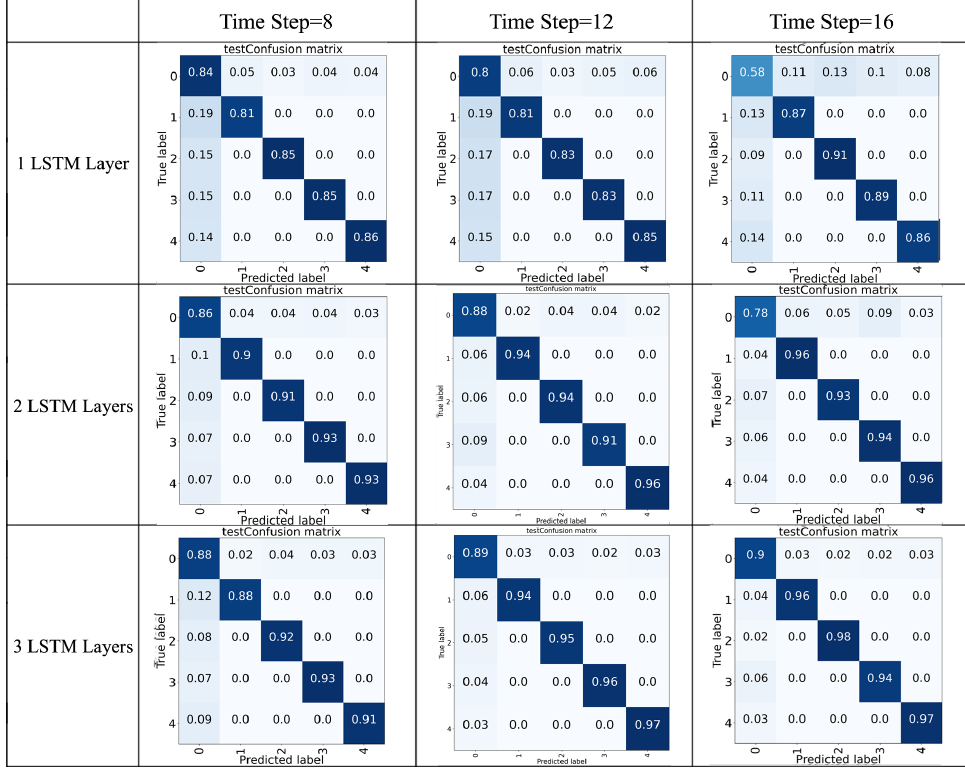
Figure 9. Confusion matrices for the proposed LSTM networks with different layers and time steps. (darker color represents higher